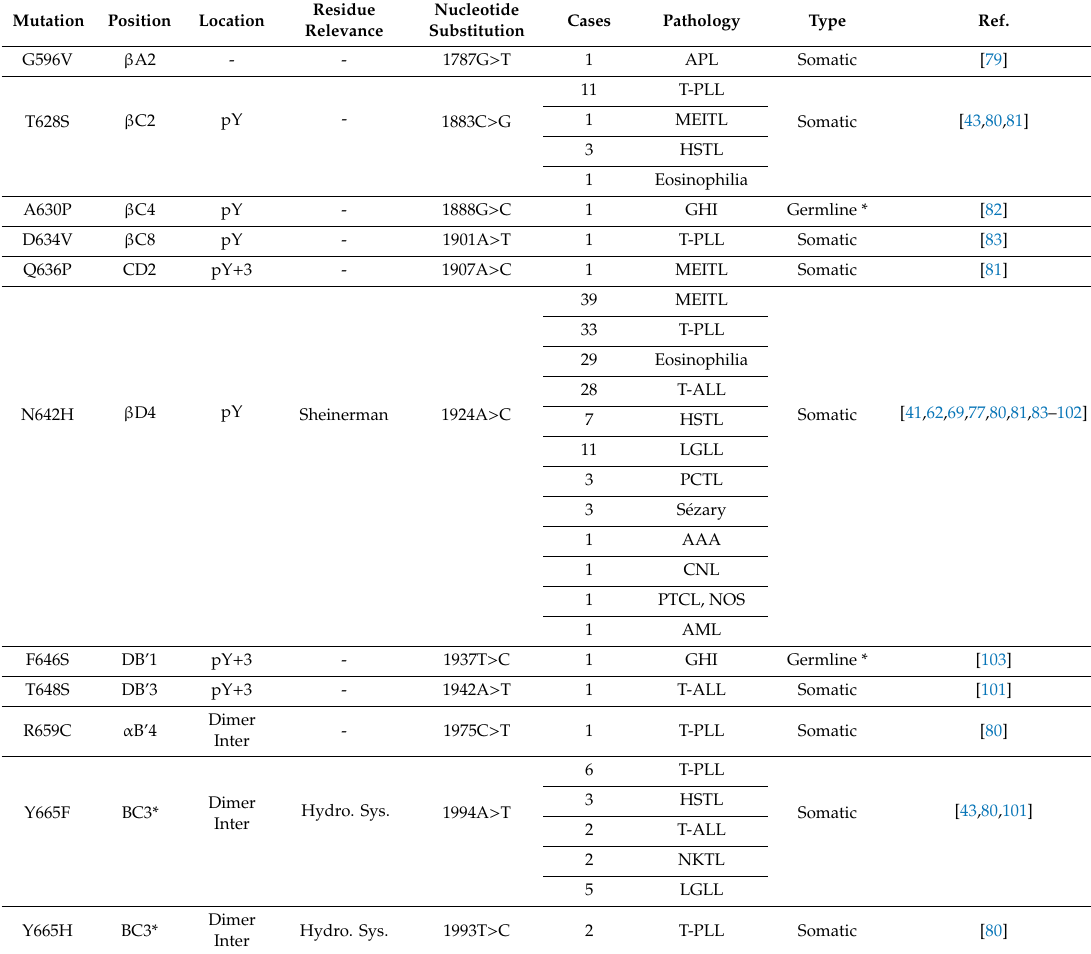
Table 2. Disease-associated mutations in the STAT5B SH2